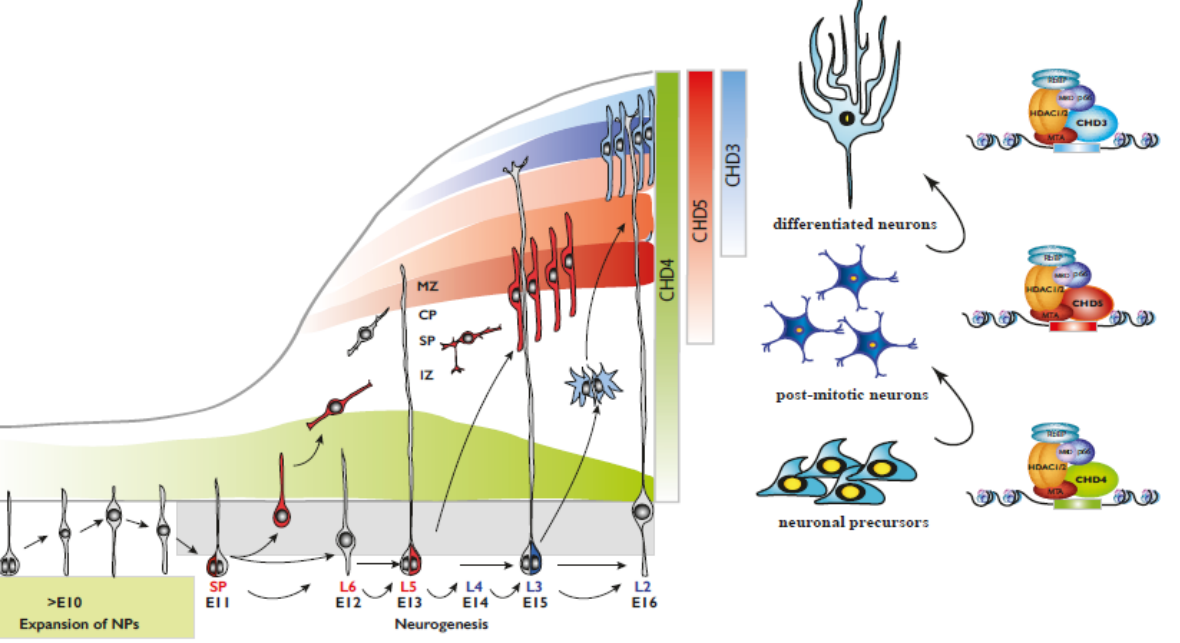
Figure 2. ( Left ) Representation of mammalian corticogenesis. Arrows indicate lineage relationships. Neuroepithelial cells undergo symmetric cell division to produce an initial pool of cortical progenitors that later transform into ventricular radial glial cells (vRGCs). vRGCs divide asymmetrically and generate another vRGC and a nascent projection neuron. The neuron migrates radially from the ventricular zone (VZ) along the basal process of an RGC into the cortical plate (CP). The earliest born neurons migrate to form the preplate and later migrating neurons split the preplate into the marginal zone (MZ) and the subplate (SP). IZ, intermediate zone; SP, subplate; CP, cortical plate; MZ, marginal zone. ( Right ) CHD paralog switching during corticogenesis. The NuRD complex has been shown to participate in all phases of brain develop- ment, from neuronal progenitor expansion, neuronal di ff erentiation and migration to the establishment and maintenance of neuronal connectivity [14,30]. During the early phases of cortical development, neuronal progenitors located in the ventricular zone of the brain undergo asymmetric division to generate both neuronal precursors that will di ff erentiate, and other progenitors that will replenish the proliferative pool. Conditional deletion of CHD4 in the murine brain results in a dramatic decrease in neuronal progenitors and a decrease in the thickness of the cortex [8,14]. Interestingly, mutations and deletions of CHD4 in humans have the opposite e ff ect with patients showing, among other morpho- logical defects, a remarkable overgrowth of the brain [31]. A potential explanation may